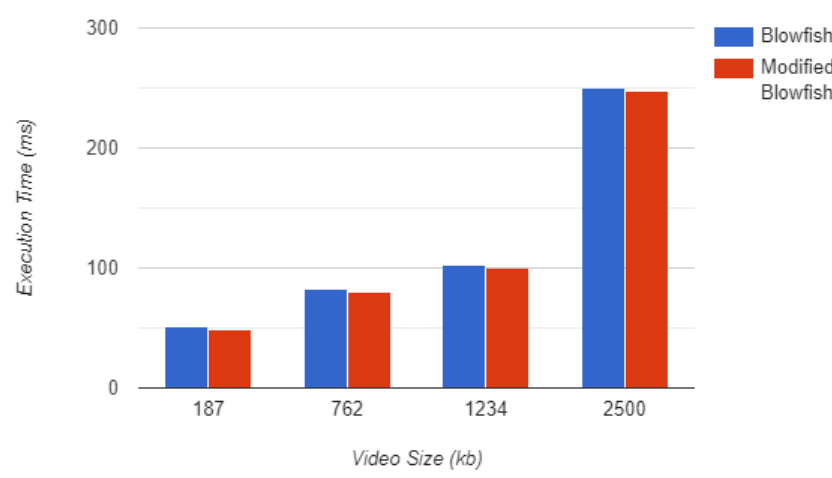
Figure 6. Experimental Results for video data types based on time complexity.